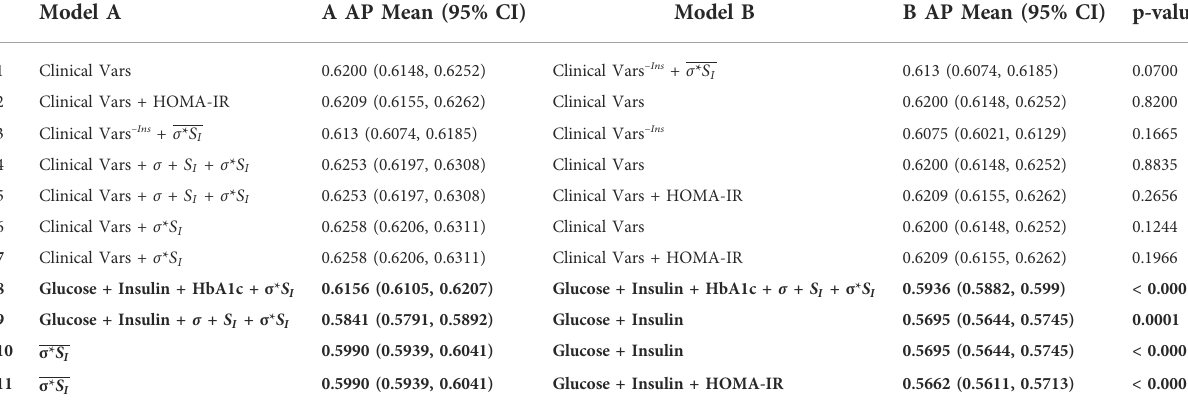
TABLE 6 Average precision comparisons between models trained on subsets of features with and without data assimilation. Models are presented in the same order as in Table 5. Clinical Vars refers to all clinical features in Tables 2, 3 except pre-operative IGM status and HOMA-IR. Clinical Vars – Ins refers to the same set of features in Clinical Vars after removing insulin measurements. Overlined parameters were estimated without insulin values. Signi fi cant p -values for two-tailed Student ’ s t -test after Bonferroni correction are shown in bold ( p <